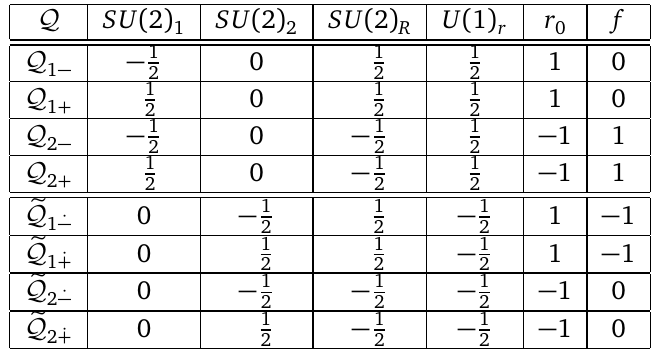
Table 1: For each supercharge Q we list its quantum numbers. Here a = 1,2 are the SU ( 2 ) indices and α = ± , ˙ α = ± are the Lorentz indices. E is the conformal R ) the Cartan generators of the SU ( 2 ) dimension, ( j , j 1 2 ( R , r ) , the Cartan generators of the SU ( 2 ) R-charge and f is the flavor